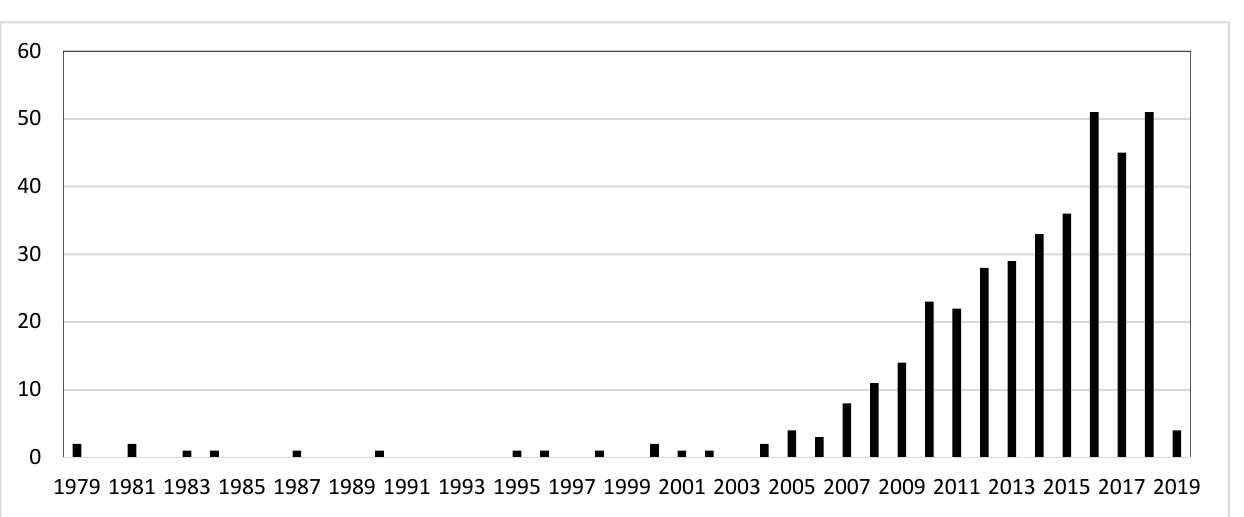
Figure 1. Distribution of articles during 1979–2019.